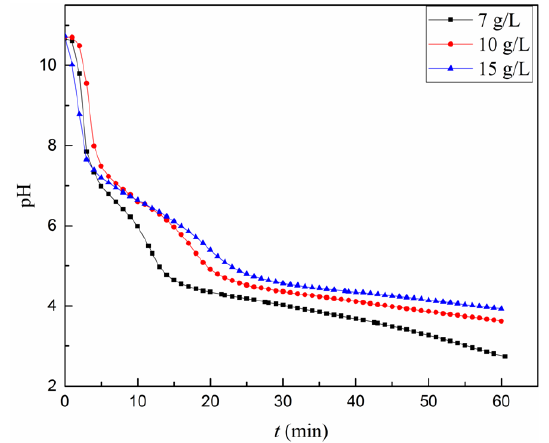
Figure 5. Changes in pH with red mud slurry concentration.